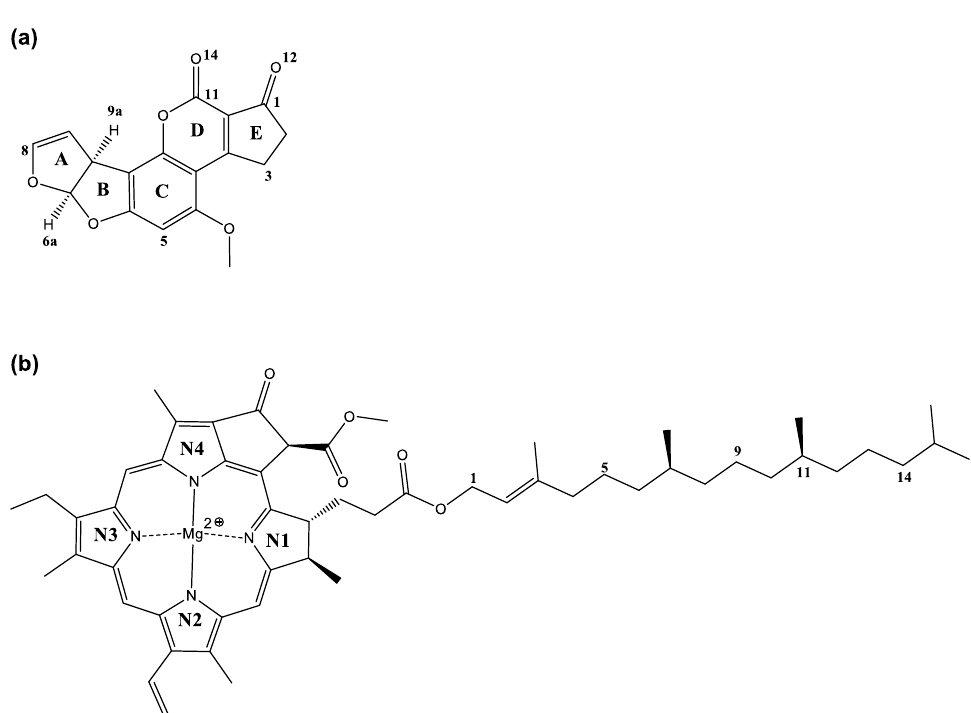
Figure 1. Structures of ( a ) aflatoxin B 1 and ( b ) chlorophyll a ( chl a